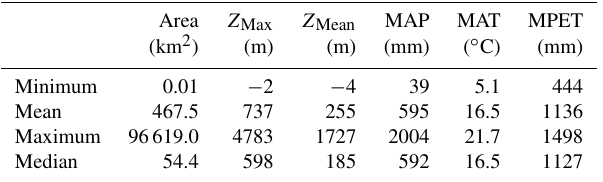
Table 2. Statistical summaries for the catchment climatic parame- ters maximum altitude ( Z Max ), mean altitude ( Z Mean ), mean annual precipitation (MAP), mean annual temperature (MAT), and mean potential evapotranspiration